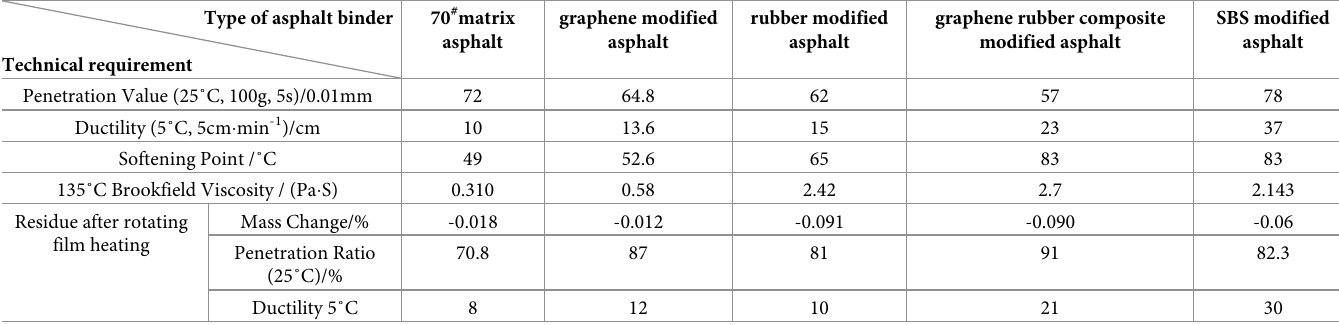
Table 7. The index values of different types of asphalt binders.